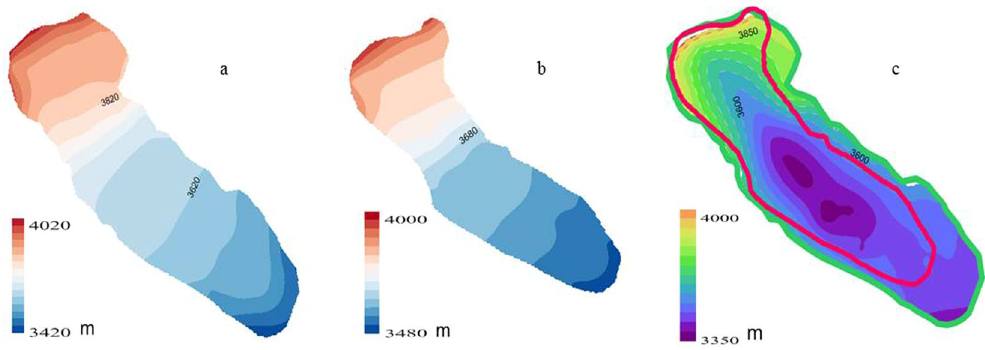
Figure 2. The surface and subglacial terrain of H8. ( a ) The surface terrain of H8 in 1969; ( b ) the surface terrain of H8 in 2009; ( c ) the bottom topography of